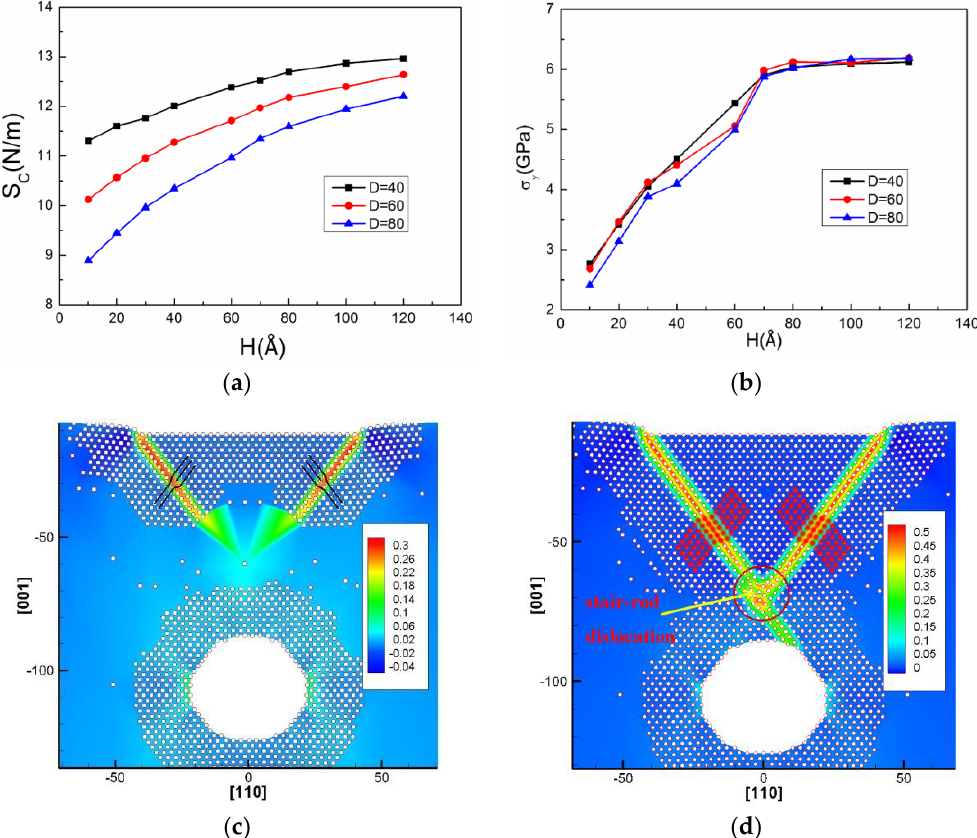
Figure 4. ( a ) Contact stiffness ( S c ) and ( b ) yield stress ( σ y ) of the Al with a circular cavity at different depths ( H ), respectively. The dislocation morphology in the matrix with the cavity ( H = 80 Å, D = 40 Å, S = 80 Å) ( c ) at the yield point and ( d ) further yielding.